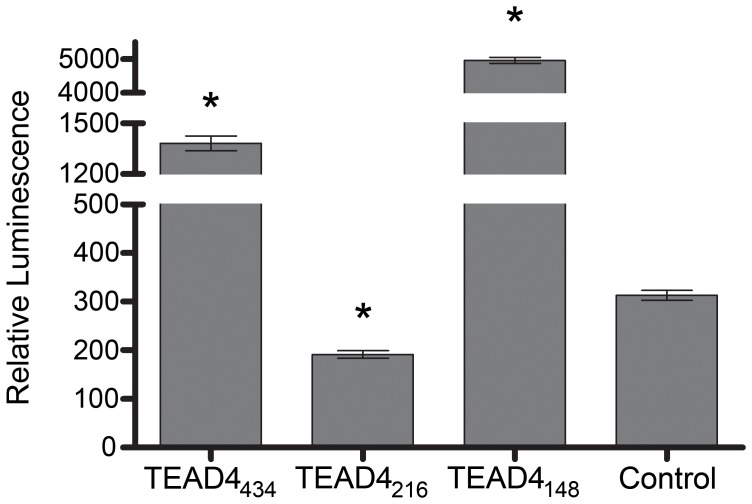
The TEAD4216 isoform represses VEGF promoter activity.The TEAD4216 isoform can repress expression from the full length human VEGF promoter F1–R3 (p<0.01, n = 9) in contrast to the TEAD4434 and TEAD4148 enhancers.